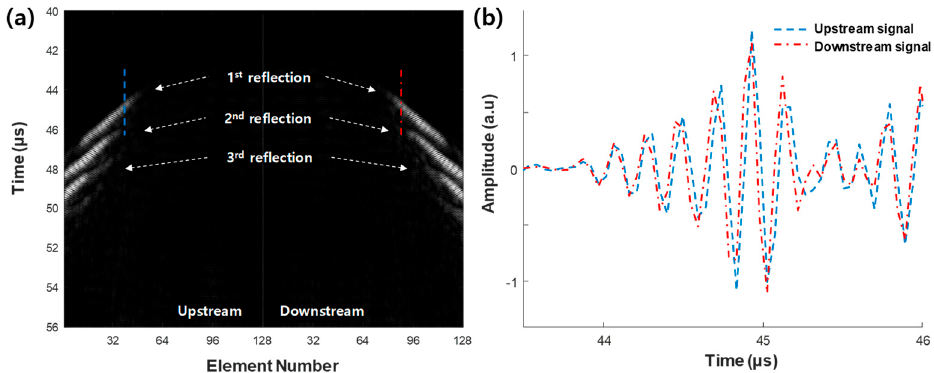
Figure 5. Ultrasonic ( a ) 2D images and ( b ) signals of upstream (blue dashed line) and downstream (red dash-dotted line) at a flow rate of 35 L / min. Dashed and dash-dotted lines in ( a ) are the positions where the ultrasonic signals in ( b ) are displayed. The arrows indicate the 1st, 2nd, and 3rd reflections.